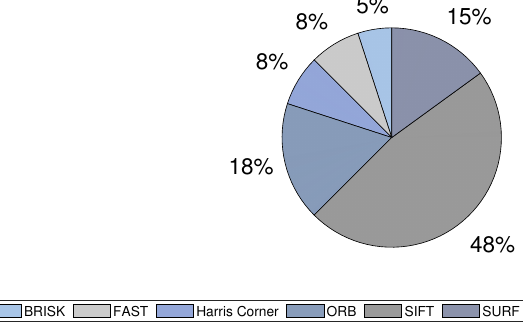
Figure 10. Global single transforms implemented on UAVs.